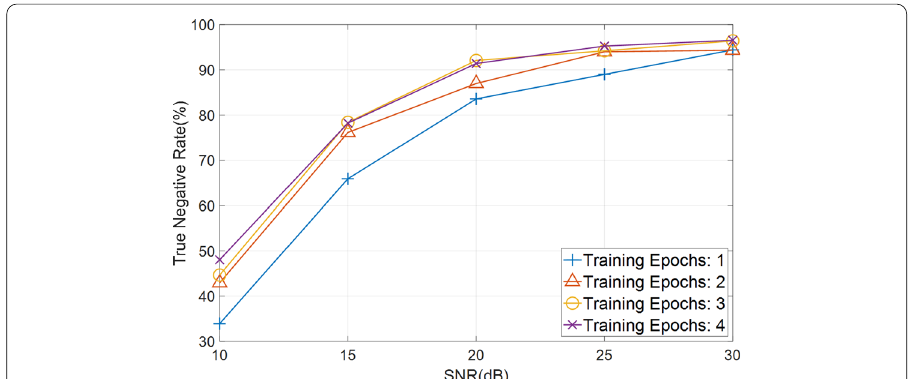
Fig. 22 Relationship between the accuracy of rogue devices and SNR (True Negative Rate). The relationships between identification accuracy and SNR are shown in this figure when training five times for rogue devices